Question: Summarize what this figure shows in one sentence.
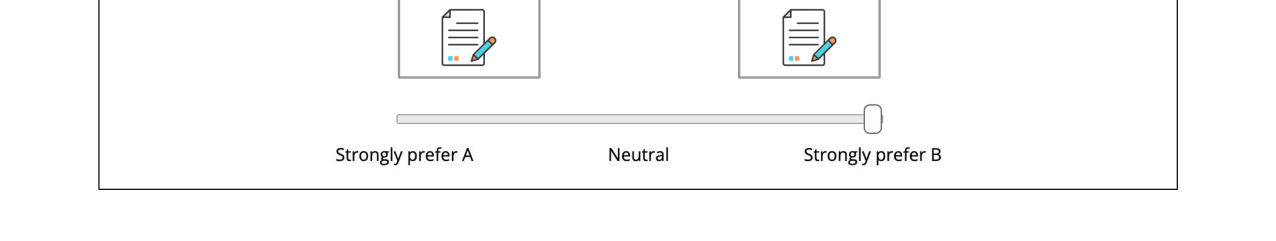
Answer: The evaluation task description for teachers. In each evaluation, we ask the teacher to compare two worksheets in terms of their effectiveness in improving the student’s test performance, and we show the teacher two sample test questions. Teachers can indicate their preference by adjusting the slider.